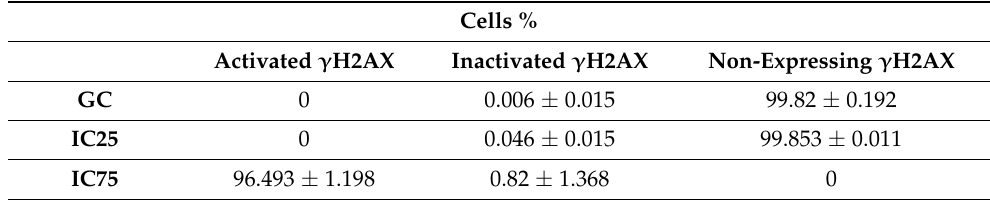
Table 3. Results of genotoxicity from γ H2AX assay.